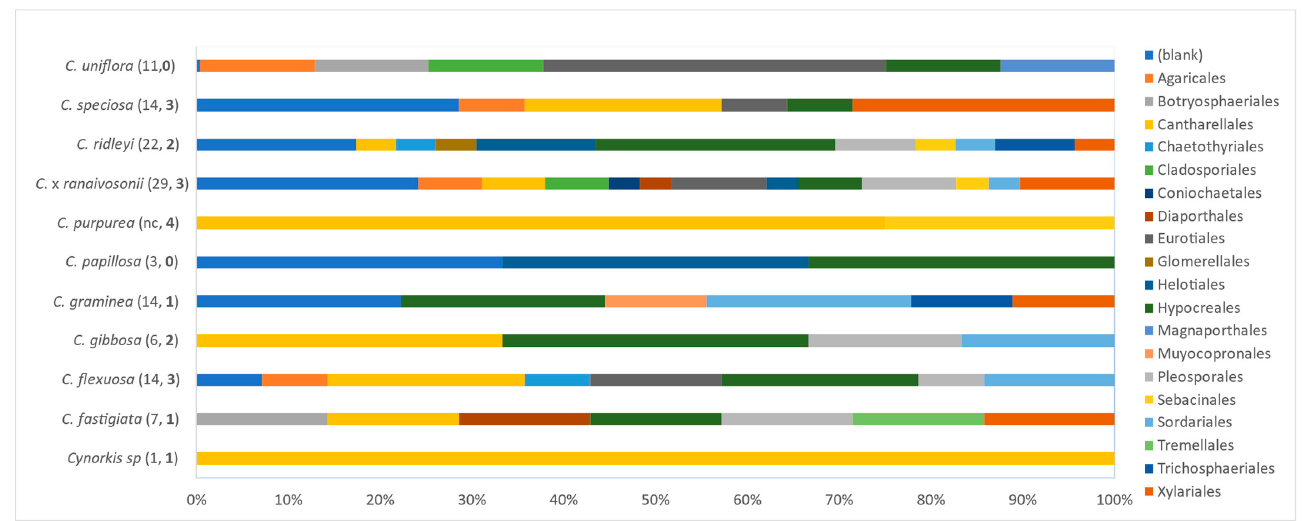
Figure 8. Proportion of mycorrhizal and non-mycorrhizal orders in 11 species of Cynorkis (total number OTUs and mycorrhizal OTUs (in bold) in brackets, nc—non-mycorrhizal fungi not counted for C. purpurea ).